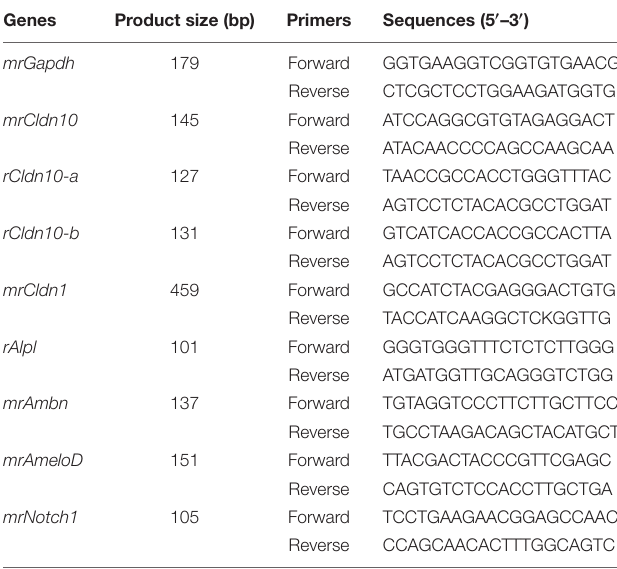
TABLE 1 | RT-PCR and RT-qPCR primers used in the current